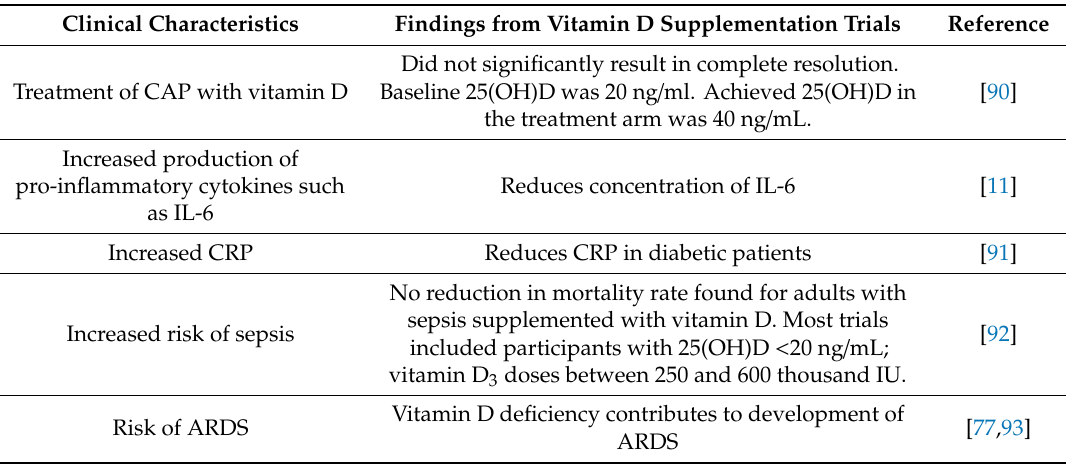
Table 3. How vitamin D supplementation is related to the clinical and epidemiological findings for